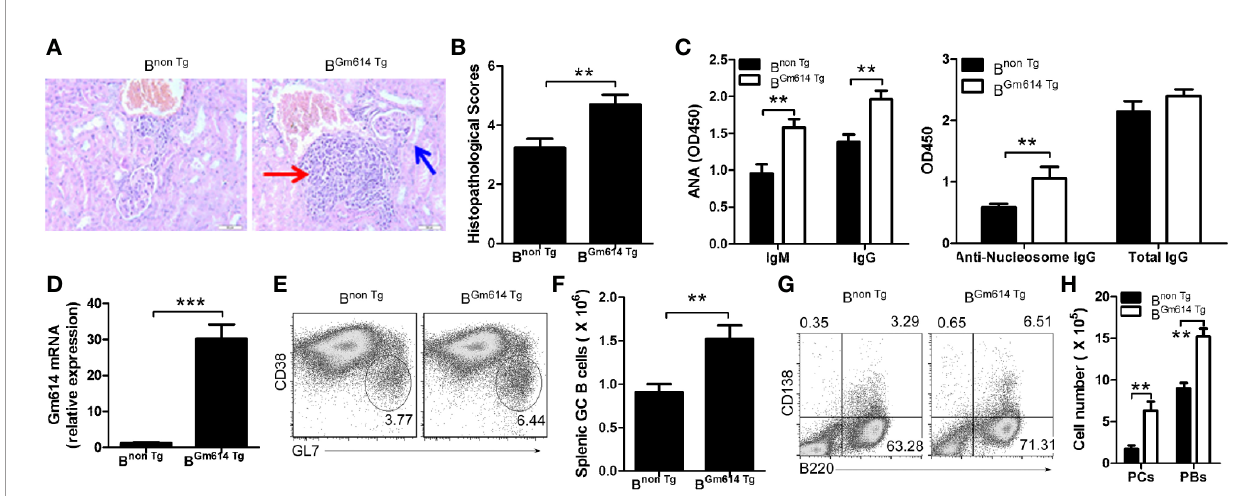
FIGURE 3 | Gm614 transgene (Tg) in B cells (B Gm614 Tg ) exacerbated symptoms in pristane-induced lupus. Nine-week-old B non Tg and B Gm614 Tg mice were i.p. injected with 0.5 ml pristane and analyzed 6 months after injection. (A) Gm614 Tg promoted in fl ammatory cells to in fi ltrate into the kidney in pristane-induced lupus. H&E-stained sections of the kidney. Scale bars, 50 µM. Blue arrows show glomeruli; red arrows show in fi ltrated in fl ammatory cells that appeared in the surrounding interstitial vasculature. (B) Gm614 Tg up-regulated histopathological scores of kidney. Histopathological scores were assessed based on loss of brush border, grading of tubular necrosis, tubular dilatation, and cast formation in 10 randomly chosen, non-overlapping fi elds. (C) Gm614 Tg up-regulated autoantibodies in pristane-induced lupus. Anti-nucleic antibodies (ANA) IgM and IgG, anti-nucleosome IgG, and total IgG were determined in the sera using ELISA assay. (D) Gm614 was overexpression in B Gm614 Tg mice. Splenic CD19 + B220 + CD38 lo GL7 hi GC B cells were sorted by FACS and subject to qPCR. (E, F) Gm614 Tg up-regulated GC B cells in pristane-induced lupus. On gated CD19 + B220 + B cells, CD38 lo GL7 hi GC B cells were analyzed by FACS. The percentages (E) and absolute numbers (F) of splenic GC B cells are shown. (G, H) Gm614 Tg up-regulated PBs and PCs in pristane-induced lupus. The percentages (G) and absolute numbers (H) of splenic CD138 + B220 + PBs and CD138 - B220 + PCs cells are shown. (A – H) Data represent three independent experiments, with six samples per group per experiment. (C, H) Two-Way ANOVA was followed by Bonferroni post-tests and (B, D, F) Student ’ s t-test (two tailed), Error bars, s.e.m., **p < 0.01, ***p <